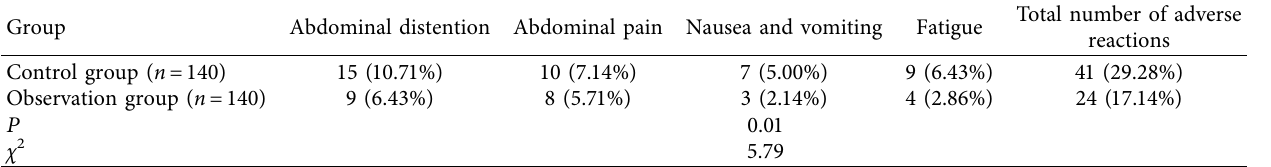
Table 4: Comparison of the incidence of adverse reactions between the two groups ( n (%)).